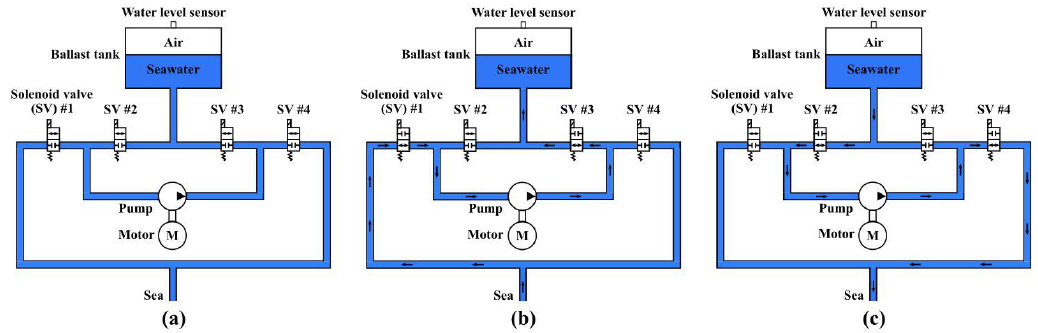
Figure 2. The schematic diagram of the on-off type VBS. ( a ) 0: close valves and turn off pump; ( b ) +1: open valves 1 and 3, and close valves 2 and 4; ( c ) −1: open valves 2 and 4, and close valves 1 and 3.